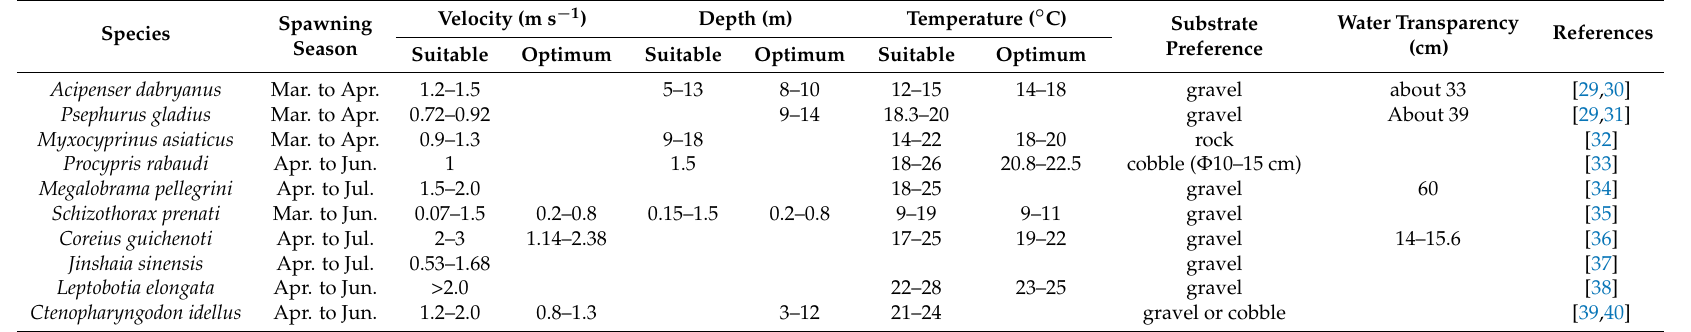
Table 1. Habitat requirements of indicator